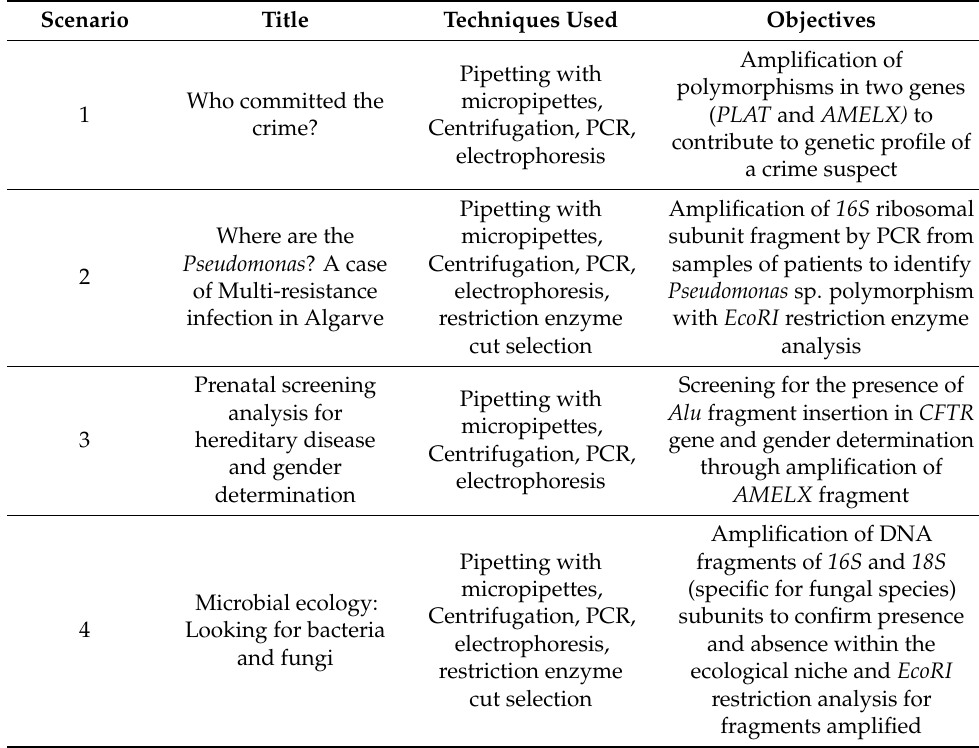
Table 1. Description of Lab-it scenarios applied during practical